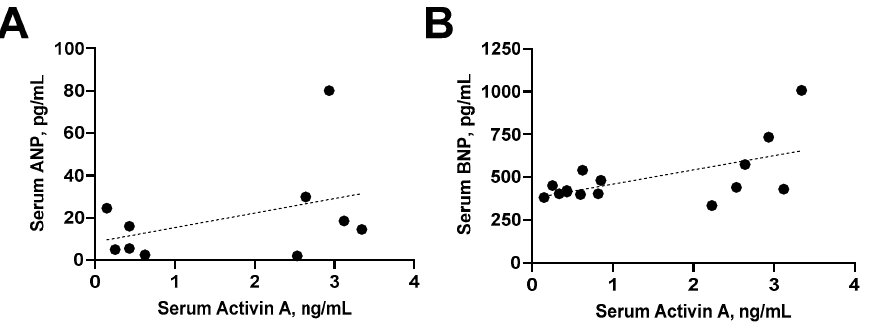
Figure 7. Relationship between activin A and circulating markers of cardiac injury. Correlation of serum activin A with serum atrial natriuretic peptide (ANP; r = 0.40, p = 0.25; ( A )) or serum brain natriuretic peptide (BNP; r = 0.58, p = 0.02; ( B )) in sham and activin A-infused (6 µg/day) pregnant rats.